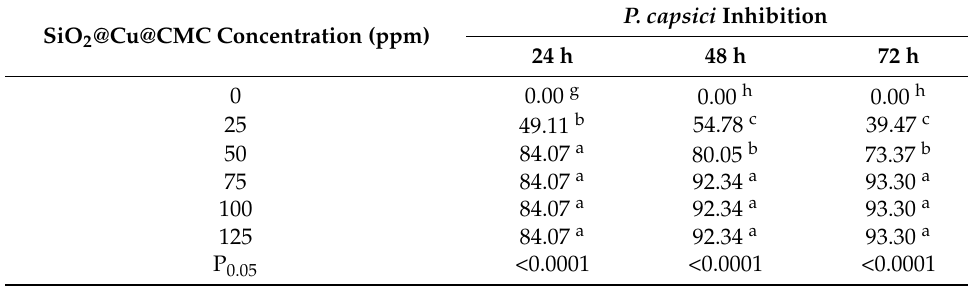
Table 1. P. capsici inhibition by SiO 2 @Cu@CMC at different concentrations. SiO 2 @Cu@CMC Concentration